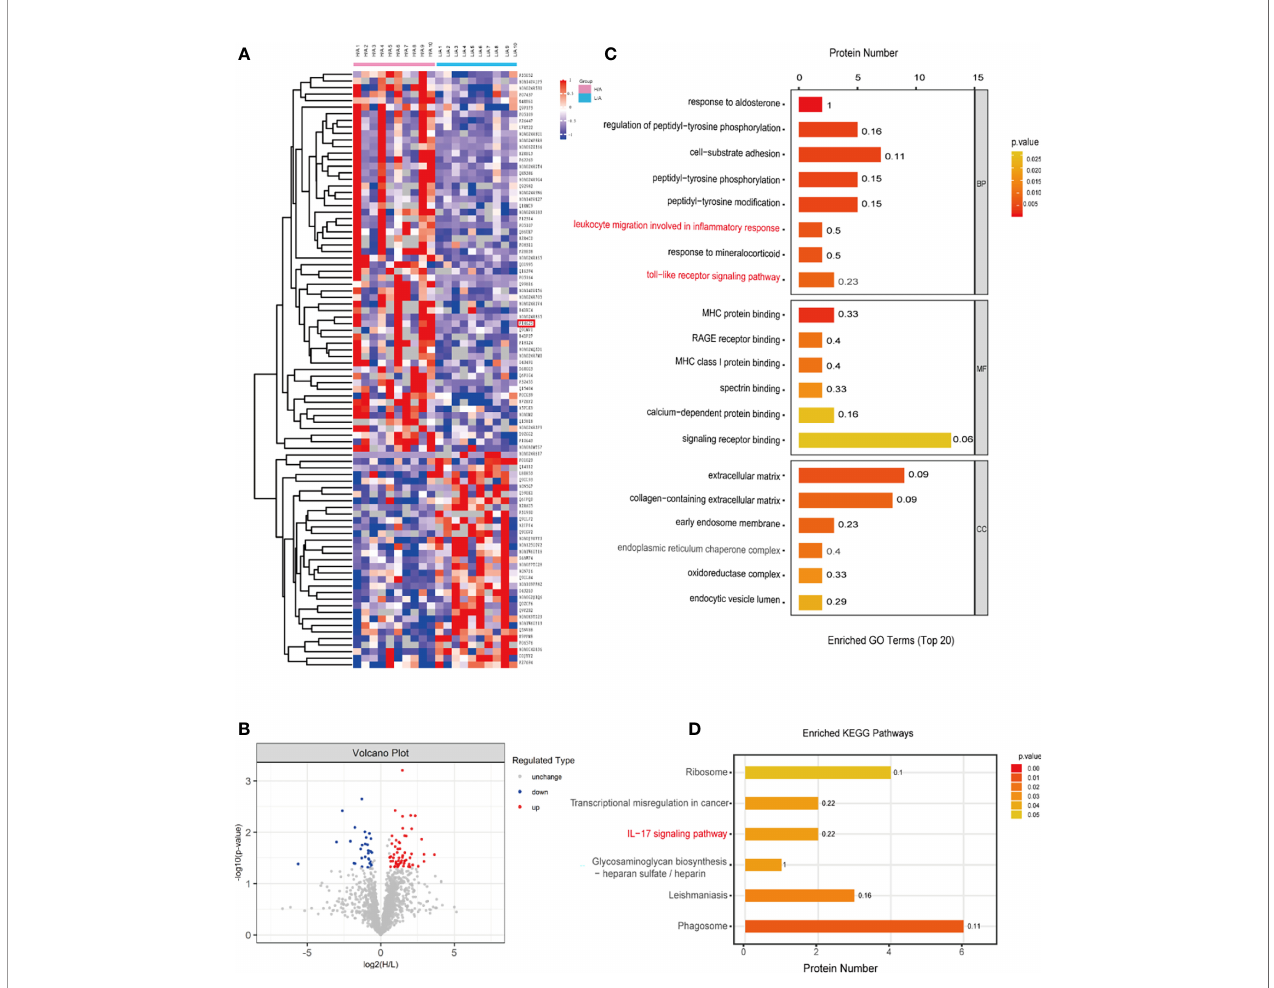
FIGURE 2 | Different PDE-EVs protein pro fi le. (A) The Heatmap showed the differentially expressed PDE-EVs proteins from the H/A group ( n = 10) and the L/A group ( n = 10). (B) Differentially regulated PDE-EVs proteins among all proteins detected in volcano plot based on fold change and p -value. (C) GO analysis for differentially expressed PDE-EVs proteins. (D) KEGG analysis for differentially expressed PDE-EVs proteins. BP, biological process; MF, molecular function; CC, cellular component.